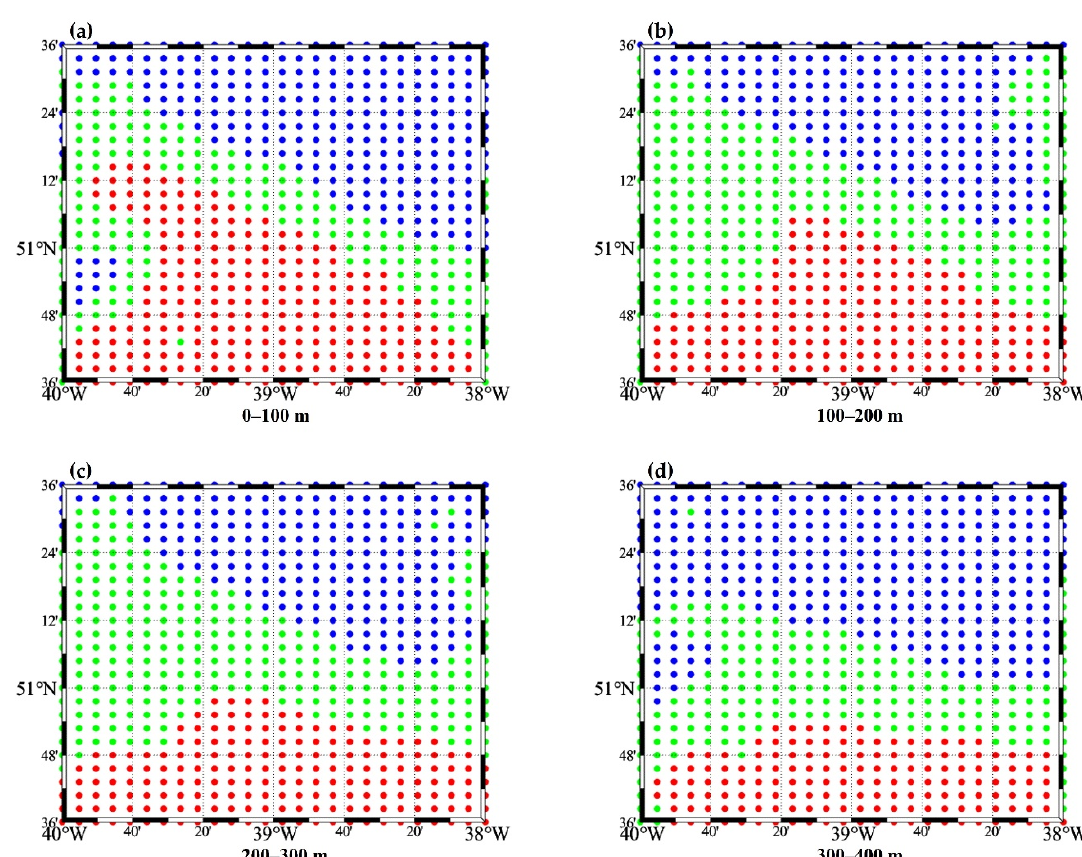
Figure 6. The iterative hierarchical clustering results of sound speed profiles of the study sea area via K-means through re-averaging the stratification of 0–200 m and 200–400 m (the blue points represent the north water mass of the frontal zone, the red points represent the south water mass of the frontal zone, and the green points represent the frontal transition water mass): ( a ) 0–100 m; ( b ) 100–200 m; ( c ) 200–300 m; ( d ) 300–400 m.